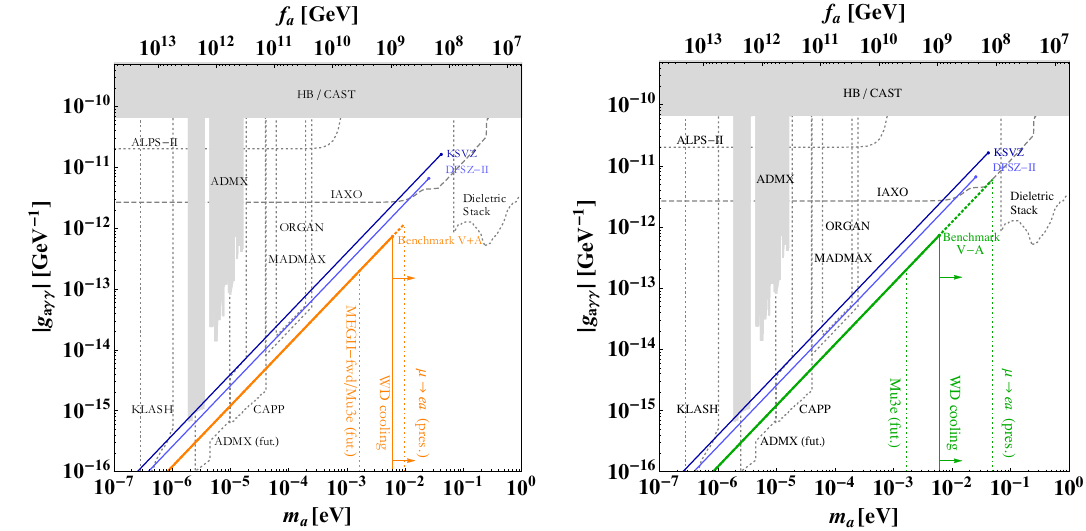
Figure 10 . Left: the “ V + A ” LFV axion corresponds to the orange bold solid line. Right: the “ V − A ” LFV axion corresponds to the green bold solid line. The grey shaded regions show the present bounds on LFV QCD axion couplings to photons as a function of axion mass for the two benchmarks. The grey dashed lines denote future projected sensitivities on the photon coupling. The solid orange/green vertical lines show the present upper bound on the axion mass from WD cooling in the two models. The dotted orange/green vertical lines show the present bound and future reach on the axion mass from LFV experiments. For a comparison we also show lines corresponding to the standard KSVZ ( dark blue ) and DSFZ-II ( blue ) models. The former one is limited by the SN1987A bound, the latter one by WD cooling. For both the DSFZ-II and our LFV QCD axion models we set β = 1 . See the main text for